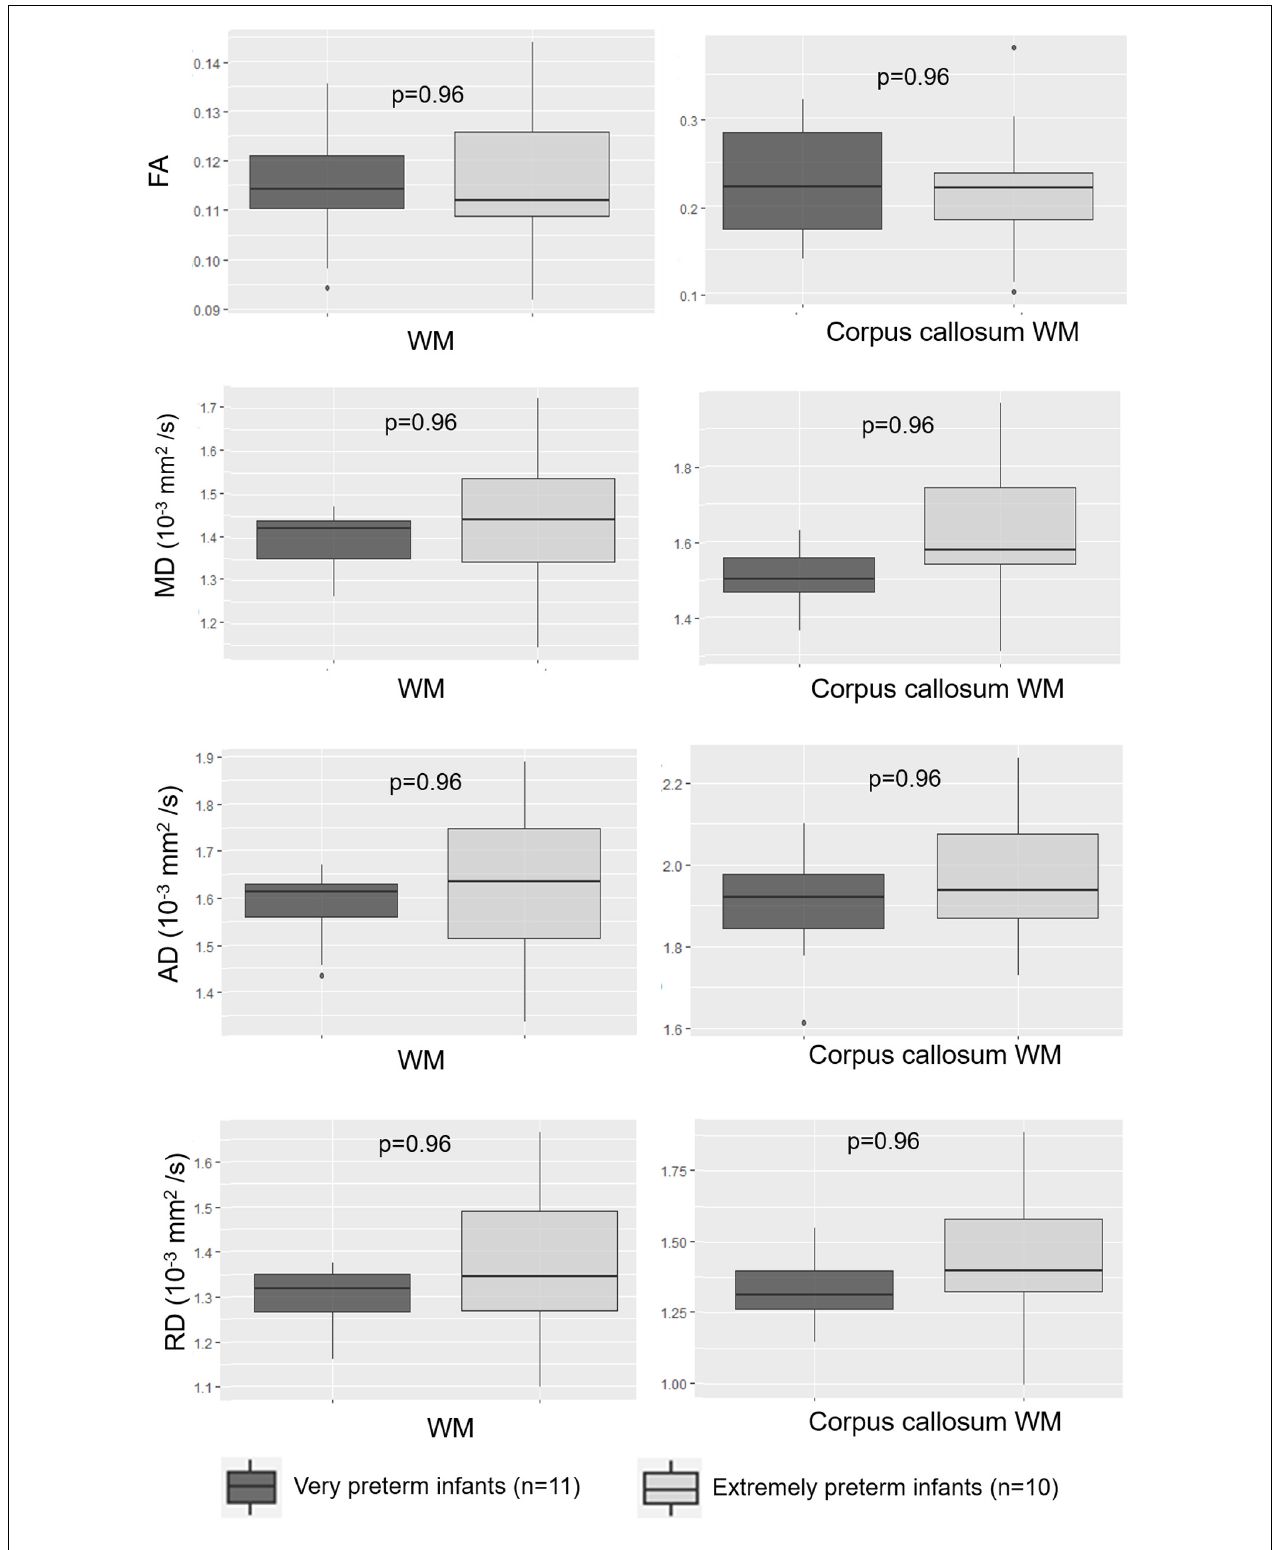
FIGURE 5 | Scalar diffusion parameters for the whole WM and corpus callosum WM according to degree of prematurity. AD: axial diffusivity; FA: fractional anisotropy; MD: mean diffusivity; RD: radial diffusivity; WM: white matter.